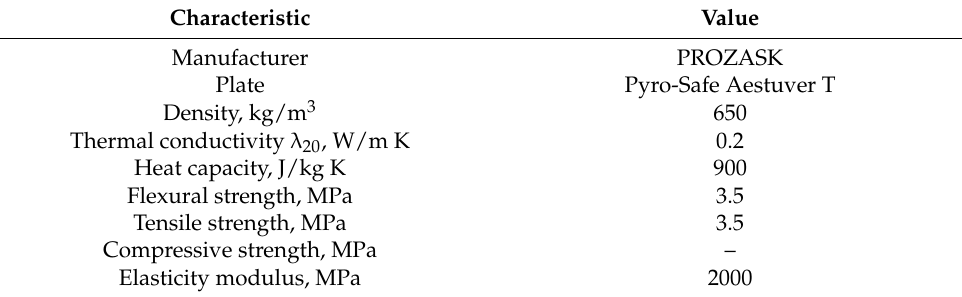
Table 3. Physical characteristics of fire